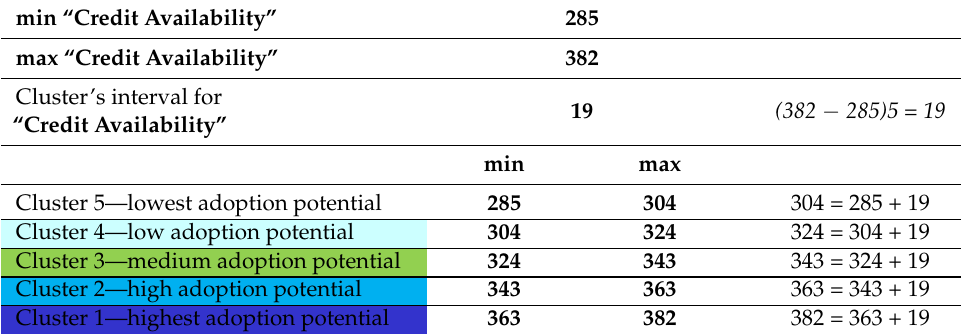
Table 10. Calculations for the “cluster interval” for variable “Credit